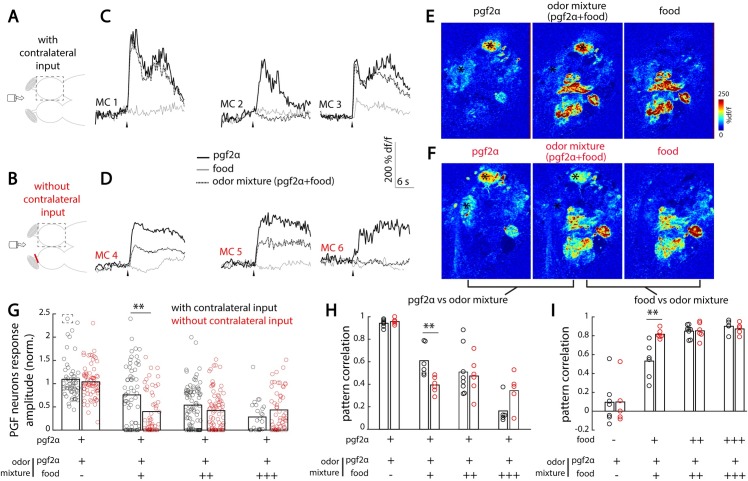
Contralateral olfactory inputs preserve reproductive pheromone detection in food odor background.(A) Illustration of the experimental setup depicting an adult zebrafish brain explant expressing GCaMP6s in excitatory neurons, and the tube for odor delivery to the intact nose. Three odors were used: pgf2α, food odor extract (food), and an odor mixture of pgf2α and food odor extract. Food odor was delivered at different concentrations (control [−]: 0 μg/mL; low [+]: 25 μg/mL; medium [++]: 100 μg/mL; high [+++]: 400 μg/mL). The dashed square indicates the imaged olfactory bulb. (B) Ventral fish brain dissection with the contralateral olfactory nerve sectioned, preventing contralateral inputs to modulate the odor responses measured. (C) Odor response time course of three representative pgf2α-selective MCs in the presence of contralateral olfactory inputs. Black arrowheads indicate odor onset. (D) Odor response time course of three representative pgf2α-selective MCs without contralateral olfactory inputs. (E) Odor response maps to pgf2α, food odor, and the odor mixture in the olfactory bulb receiving contralateral inputs. Black asterisks indicate pgf2α-selective glomeruli. (F) Odor response maps for the same fish and imaging plane than in (E), without contralateral inputs. (G) Relative response of pgf2α-selective cells to the odor mixture in all conditions. Each circle represents a pgf2α-selective MC with (black) or without (red) contralateral inputs. The response amplitude of each pgf2α-selective MC to the odor mixture is normalized to its response to pgf2α alone. Values close and superior to 1 represent conserved or enhanced responses to pgf2α in presence of food odor, respectively. Values close to 0 indicate suppression of the pgf2α response in the presence of food odor (**p < 0.01, Mann–Whitney U test). The number of pgf2α-selective MCs is as follows (with contralateral inputs): control (−), 57 MCs in seven fish; low (+), 61 MCs in six fish; medium (++), 83 MCs in eight fish; and high (+++), 25 MCs in five fish. The number of pgf2α-selective MCs is as follows (without contralateral input): control (−), 72 MCs in five fish; low (+), 53 MCs in six fish; medium (++), 77 MCs in six fish; and high (+++), 56 MCs in five fish. The response of the cell placed in a dashed square is out of range (3.3). (H) Correlation between MCs’ odor responses to pgf2α and odor mixtures for all conditions (**p < 0.01, Student t test). High and low pattern correlation values indicate high and low similarities with the pgf2α response pattern, respectively. Each circle represents correlation within a single fish, with contralateral input (in black) or without contralateral input (in red). (I) Correlation between MCs’ odor responses to food odor and odor mixtures for all conditions (**p < 0.01, Student t test). High and low pattern correlation values indicate high and low similarities with the food odor response pattern, respectively. Numerical data used to generate this figure can be found in S1 Data. GCaMP6, genetically encoded calcium sensor, circular permutated green florescent protein-Calmodulin-M13 peptide 6; MC, mitral cell; pgf2α, prostaglandin 2α.